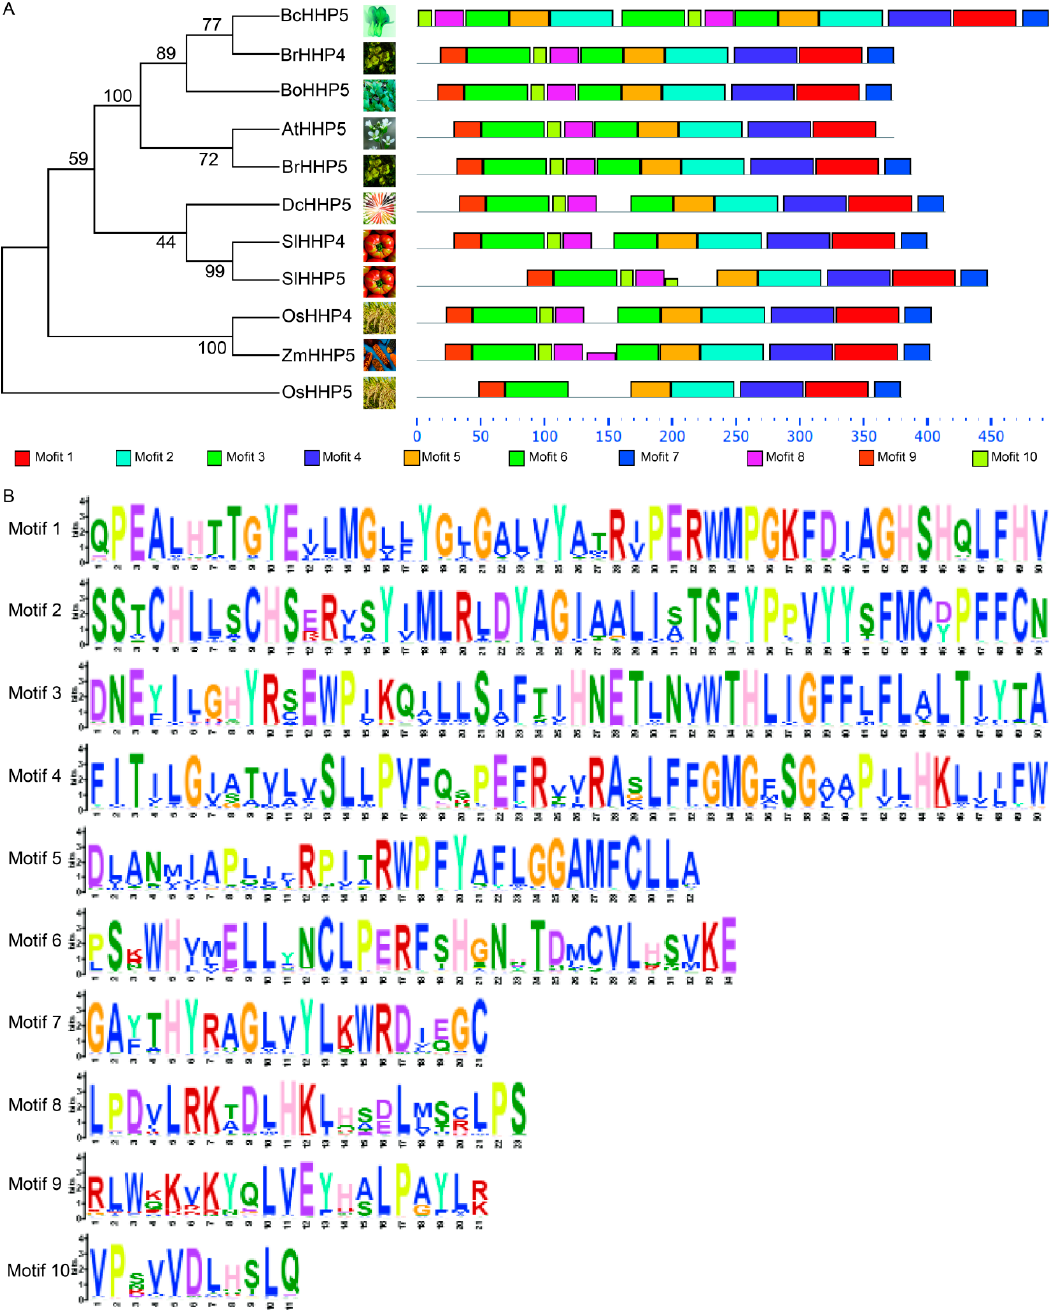
Figure 2. Conserved motifs in HHP . ( A ) Phylogenetic tree, conserved motifs, and their distribution in each HHP gene and the corresponding combined P-values; ( B ) the amino acid sequence of each motif. The font size means the frequency of the corresponding amino